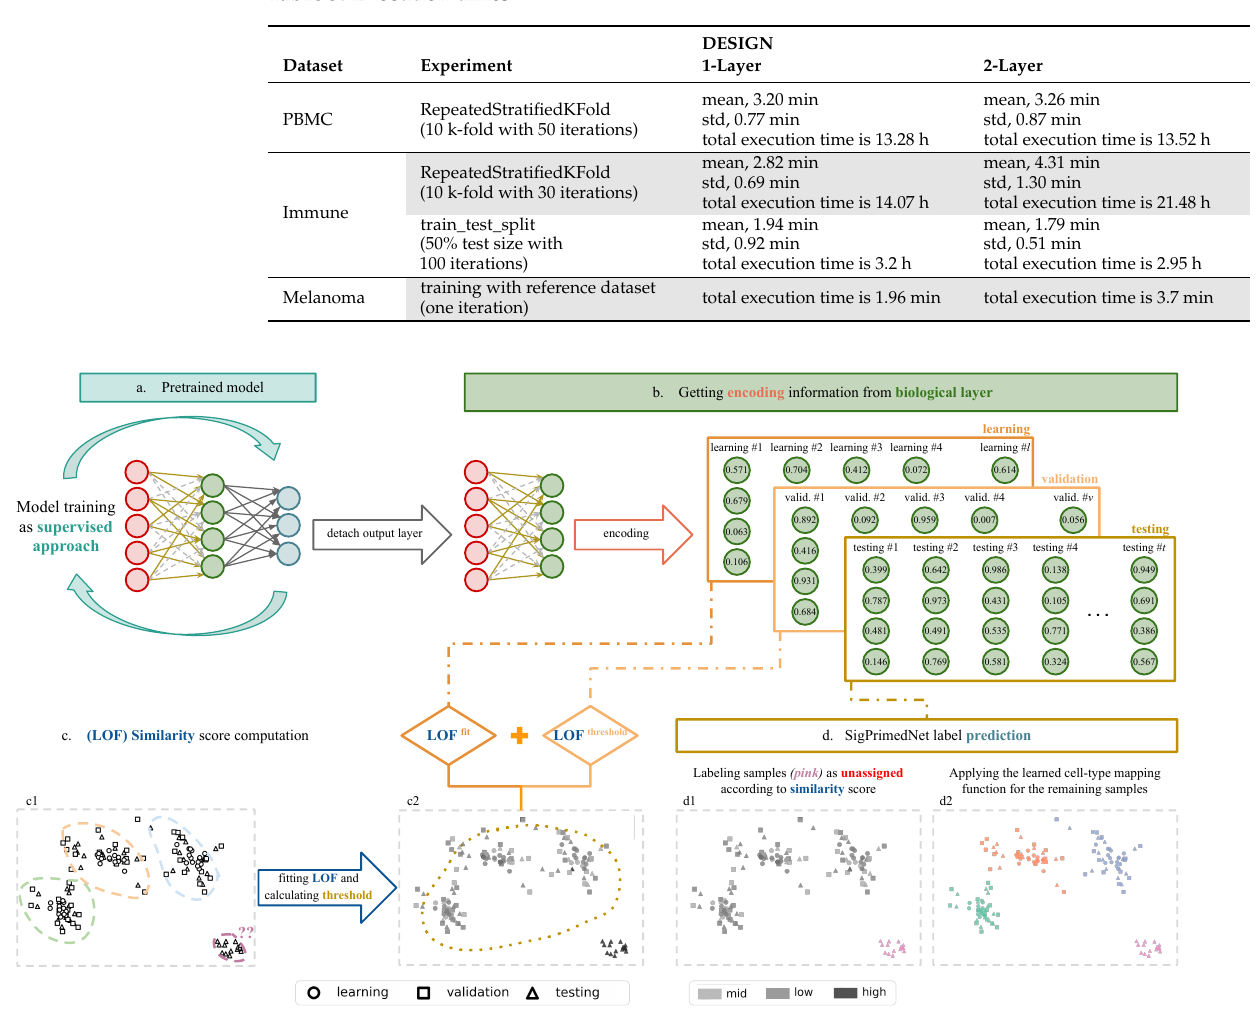
Table 3. Execution times.